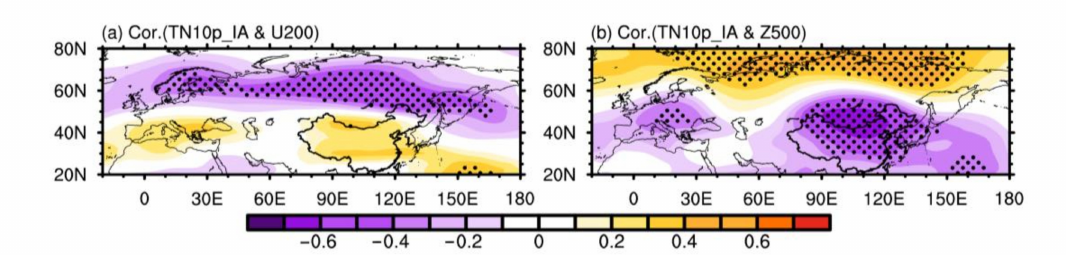
Figure 7. Correlation coefficient of the ( a ) U200 (shaded) and ( b ) Z500 (shaded) with TN10p_IA series. The dotted region indicates significance at the 95% level from the t test.